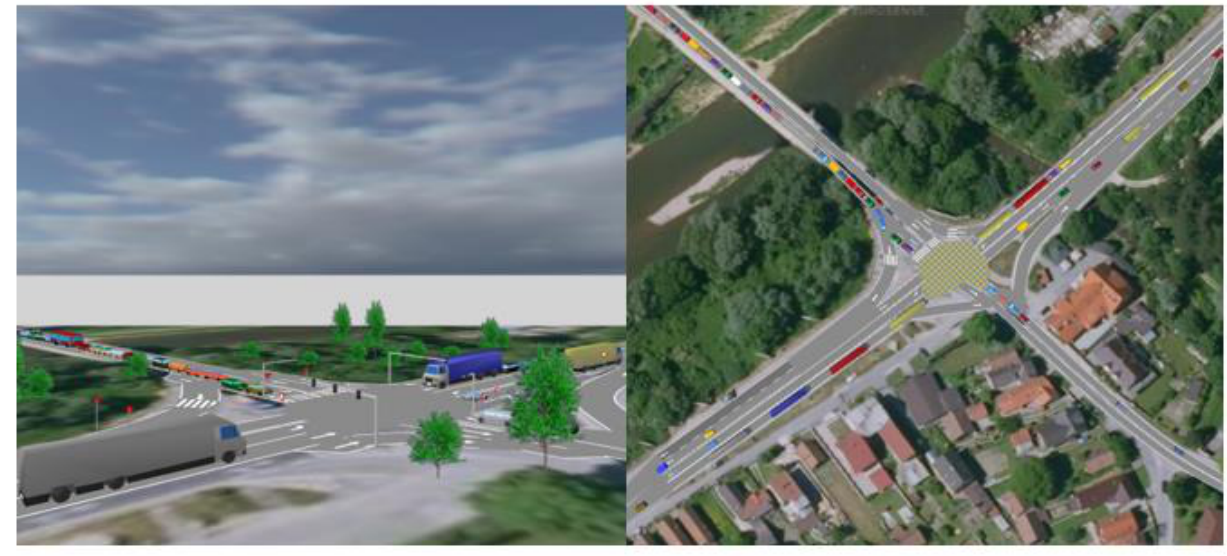
Figure 3. Modelled intersection in Aimsun and traffic simulation.